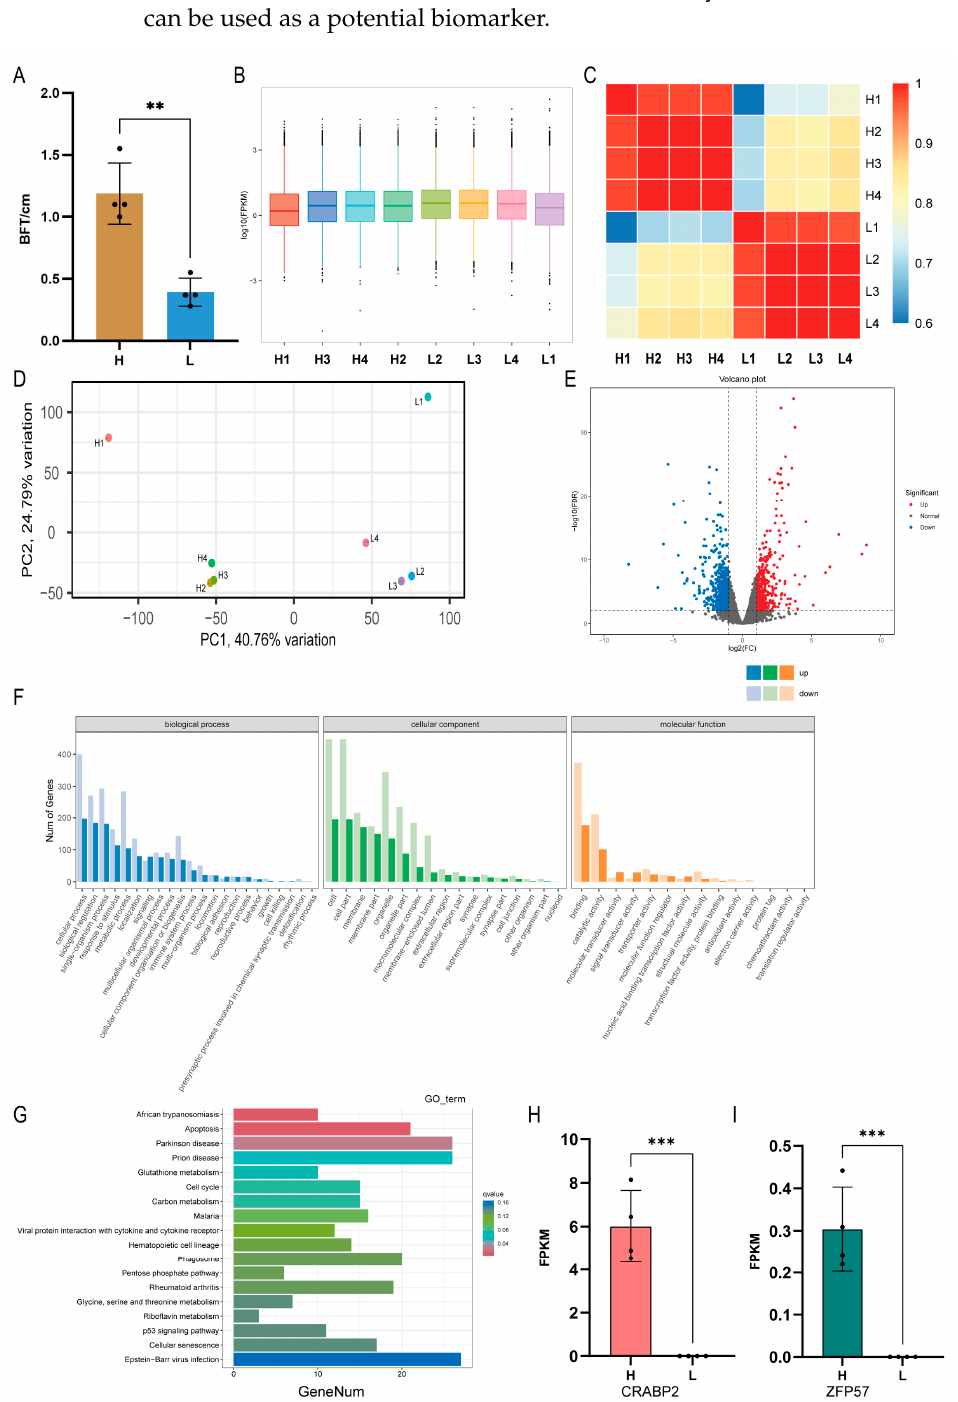
Figure 1. Basal analysis of the transcriptome and the different phenotypes profiles in the BFT ( n = 8). ( A ) Comparison of the BFT phenotypes (** means p -value < 0.05). ( B ) The FPKM boxplot for each sample. ( C ) The heatmap of expression correlation between samples. ( D ) The principal component analysis (PCA). ( E ) Volcano plots of the DEGs in the BFT. ( F ) The GO annotation analysis histogram of DEGs for BFT. ( G ) The plot of the degree of KEGG pathway enrichment for DEGs. The vertical coordinates indicate the enriched pathway, and the horizontal coordinates indicate the value of the enrichment factor (ratio of the annotated DEGs to all genes in the enriched pathway). ( H ) FPKM of CRABP2 in the H and L groups. ( I ) FPKM of ZFP57 in the H and L groups (*** means p -value <